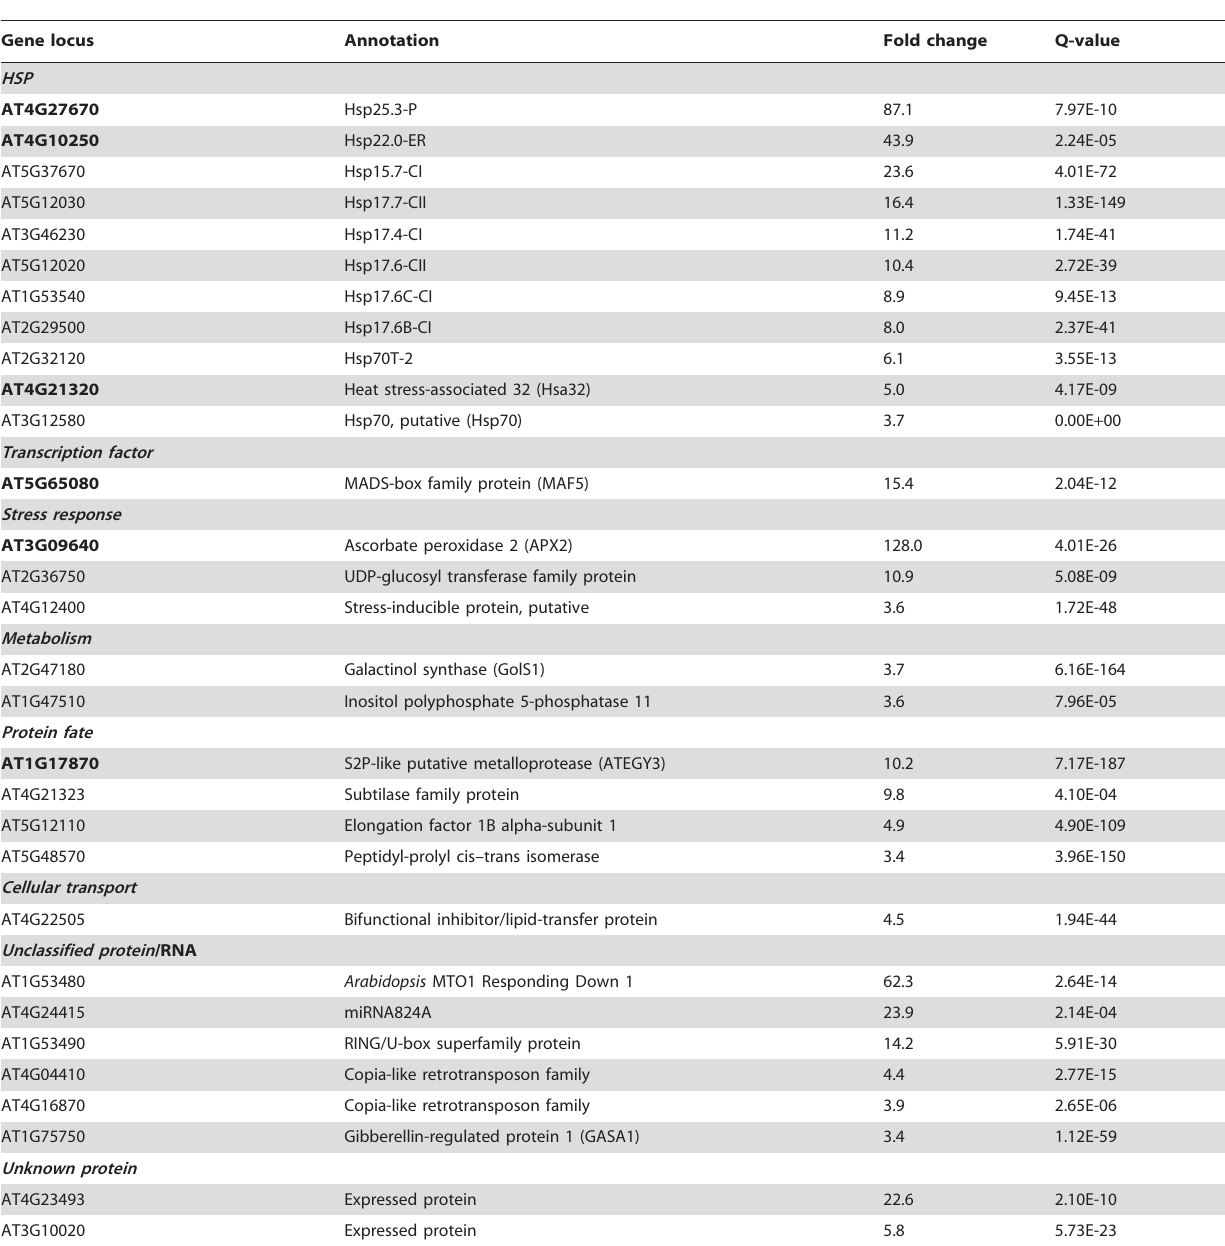
Table 1. Up-regulated genes in 35S:SlHsfA3 transgenic plants (Q-value , 0.001; fold change . 3).